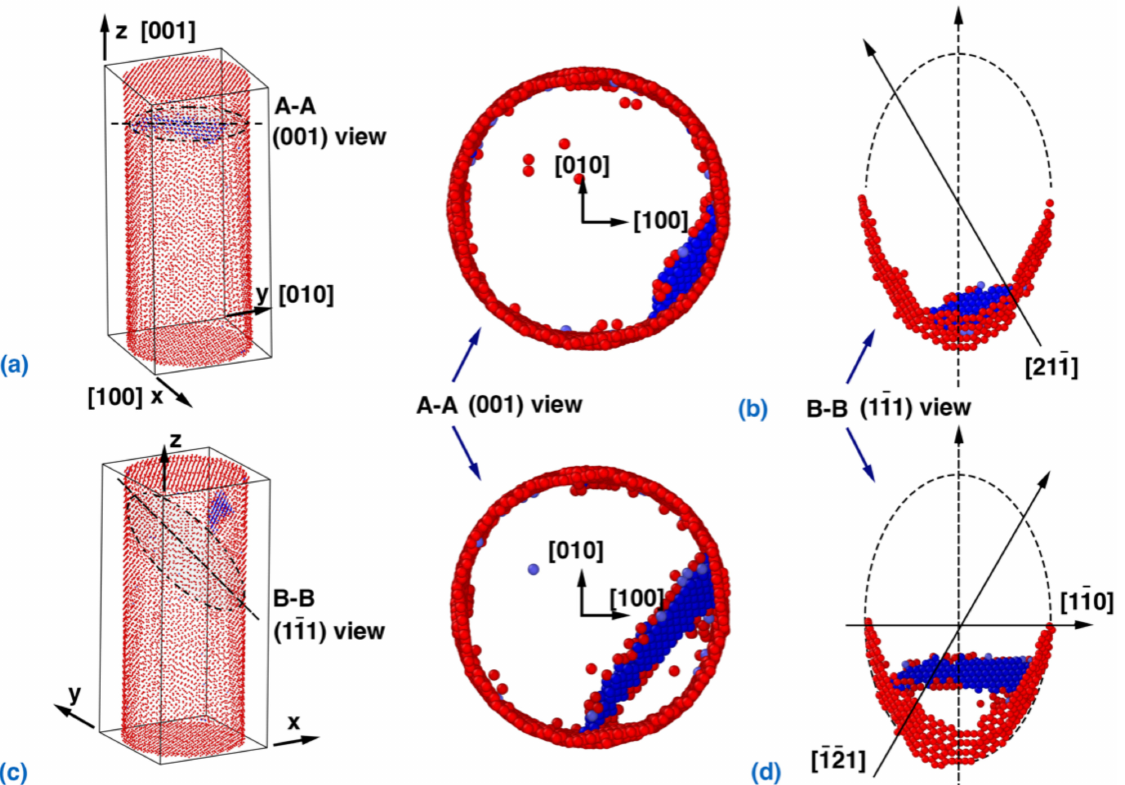
Figure 2. Dislocation nucleation and slip in the NW with a torsion/tension strain ratio of 2.6051. Development of the dislocation: ( a ) cross-sectional view of the nucleation and ( b ) the (111) plane of the nucleation. Below, a view of the dislocation formed by the trailing partial dislocations: ( c ) cross- sectional view and ( d ) the (111) plane. Atoms with the Ackland–Jones parameter (AJP) [56] equal to 0 and 3 are visualized in order to distinguish the atoms in the surface and partial dislocation/stacking faults, respectively. Specifically, AJP = 0 highlights the surface atoms (colored in red), and AJP = 3 highlights the HCP atoms (colored in blue). The FCC atoms with AJP = 2 are not shown in the figure for clarity.